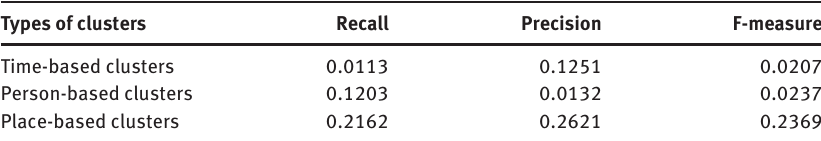
Table 4. Precision, Recall, and F-Measure for Method